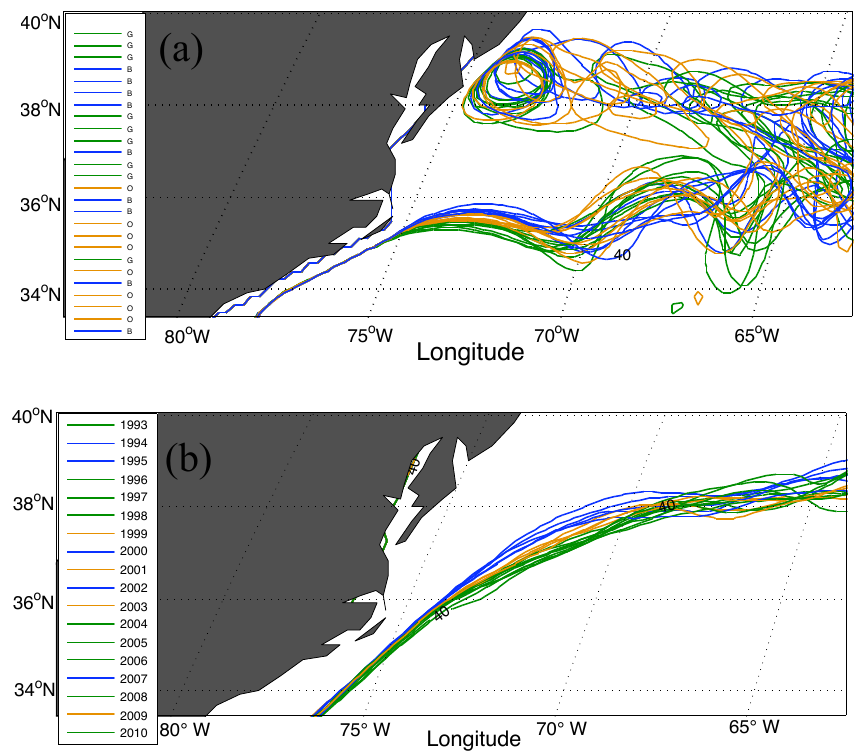
Fig. 5. (a) Paths of the modelled GS and GSE defined by the 40-cm SSH contours (the 26 curves represent the last 26 years of the integration). The blue (B) and green (G) contours show the higher and lower latitudinal locations of the jet, respectively; the orange contours (O) correspond to intermediate locations (the legend shows the temporal sequence of the contours). (b) Paths of the GS and GSE defined by the 40-cm observed absolute dynamic topography (distribuited by AVISO/Cnes). The blue and green contours show the higher and lower latitudinal locations of the jet, respectively; the orange contours correspond to intermediate locations (the legend refers to the corresponding annual average).